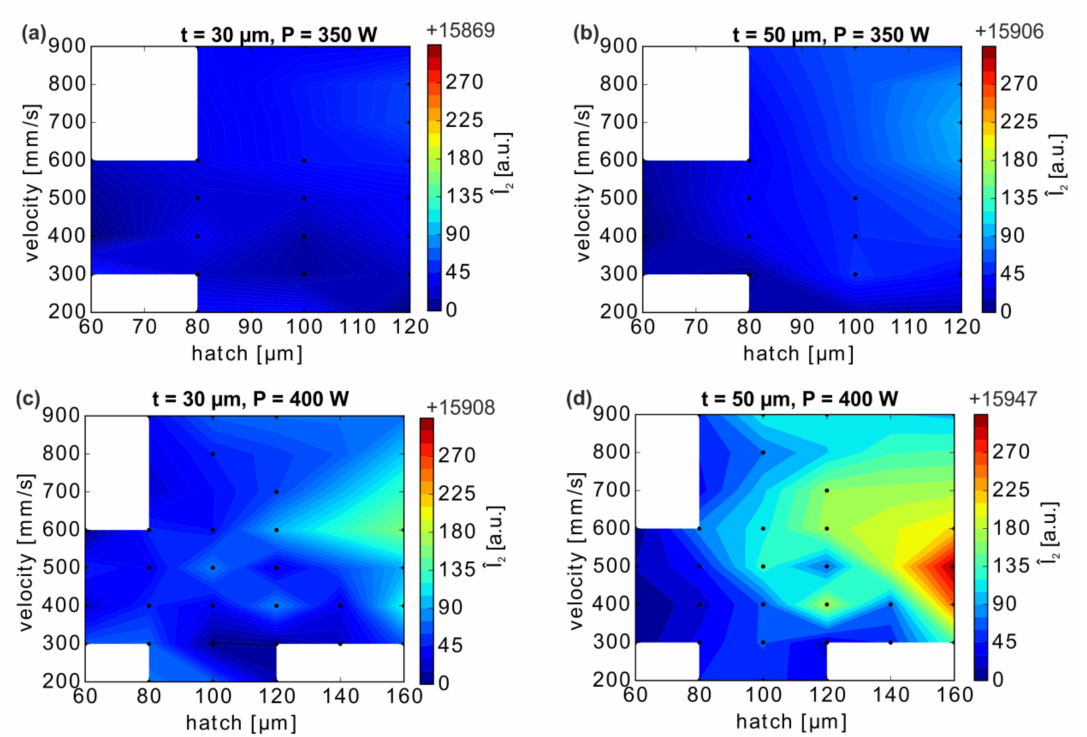
Figure 6. Volume-mean intensity Î 2 as a function of the velocity and hatch distance parameters computed for the bulk of the cuboid specimen (i.e., above the supports, 3 mm ≤ b ≤ 14 mm): ( a ) and ( c ) t = 30 µ m, ( b ) and ( d ) t = 50 µ m, for P = 350 W and 400 W, respectively. The values between the analyzed, black marked data points were linearly interpolated.